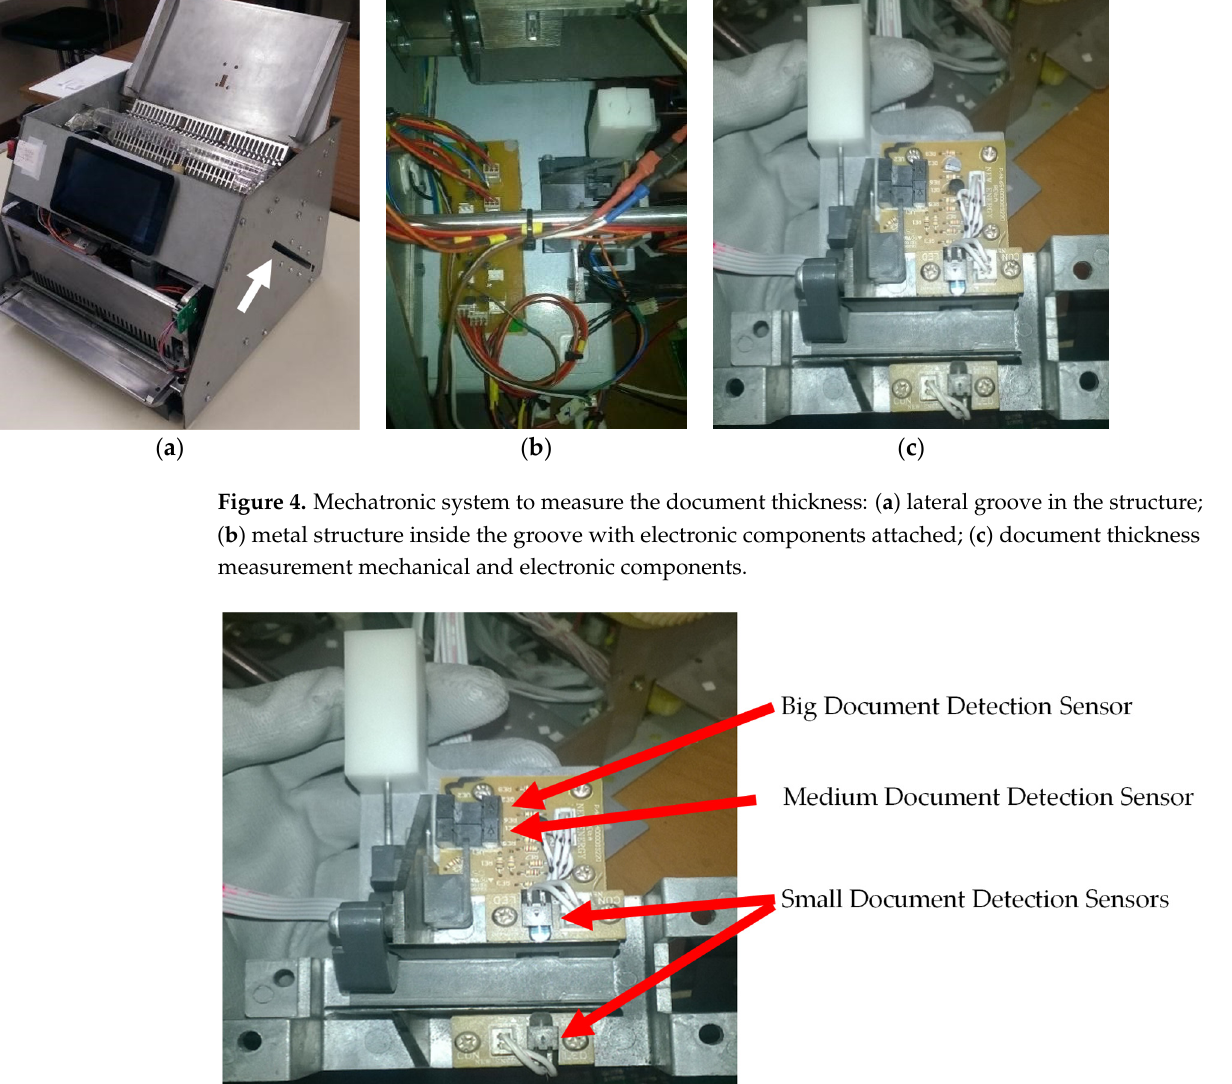
Figure 4. Mechatronic system to measure the document thickness: ( a ) lateral groove in the structure; ( b ) metal structure inside the groove with electronic components attached; ( c ) document thickness measurement mechanical and electronic components.